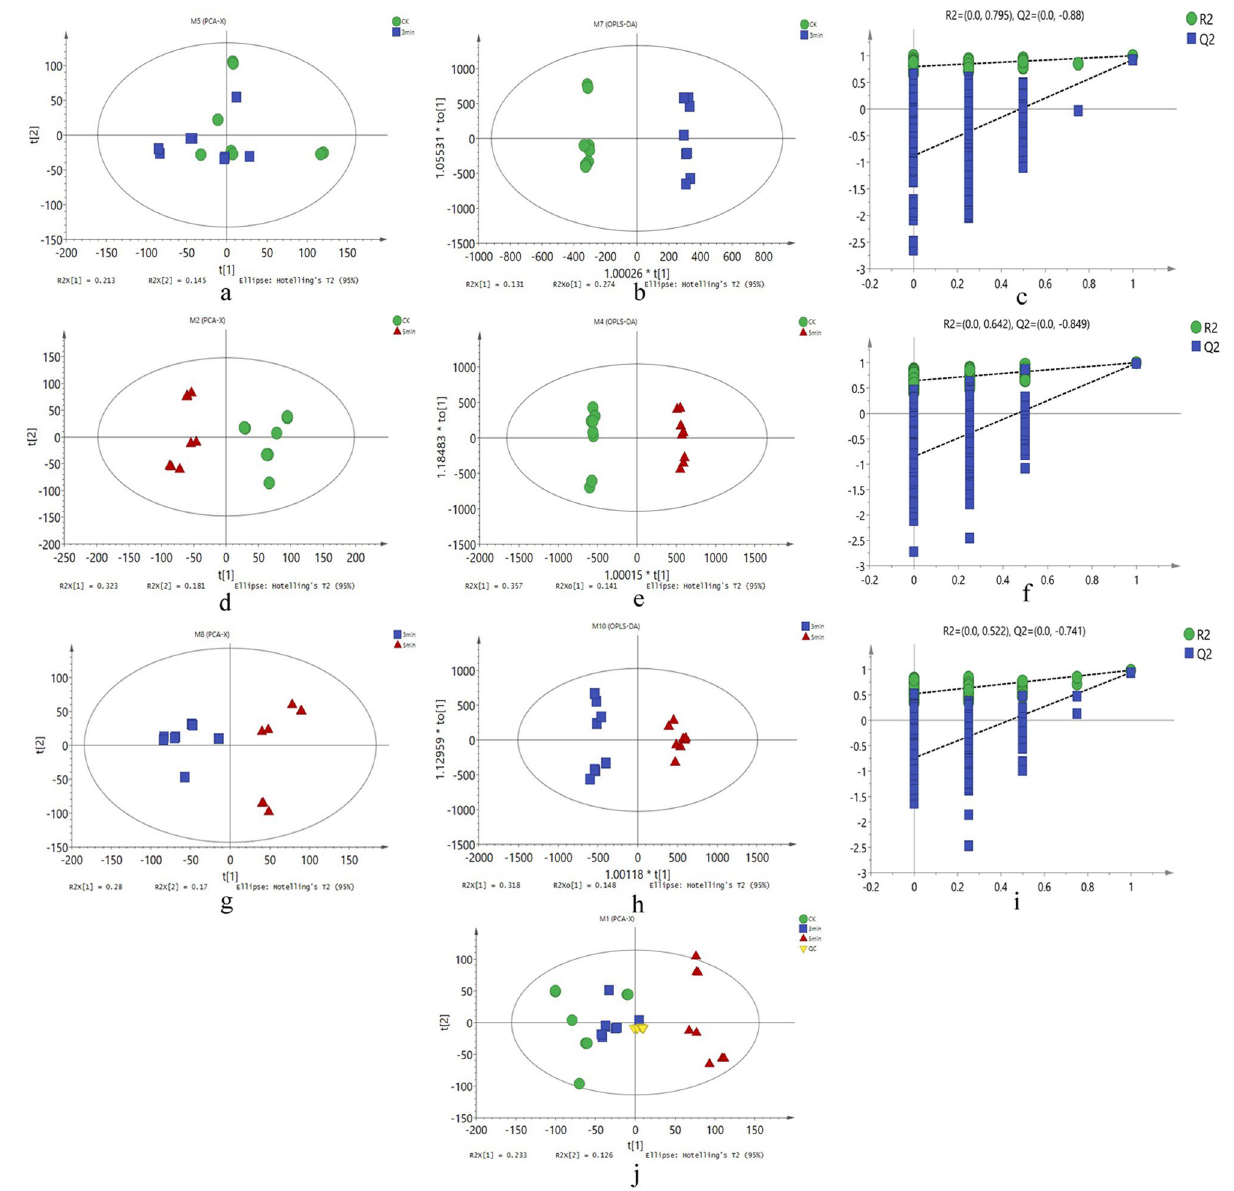
Figure 1. Score scatter plots from PCA, PLS-DA, OPLS-DA and validation plots of OPLS-DA for three comparative groups. ( a ) PLS-DA for 3 min/CK comparative group. ( b ) OPLS-DA for 3 min/CK comparative group. ( c ) Validation plots of OPLS-DA for 3 min/CK comparative group. ( d ) PLS-DA for 5 min/CK comparative group. ( e ) OPLS-DA for 5 min/CK comparative group. ( f ) Validation plots of OPLS-DA for 5 min/CK comparative group. ( g ) PLS-DA for 3 min/5 min comparative group. ( h ) OPLS-DA for 3 min/5 min comparative group. ( i ) Validation plots of OPLS-DA for 3 min/5 min comparative group. ( j) Score scatter plots of PCA for 3 min/CK comparative group, 5 min/CK comparative group and 3 min/5 min comparative